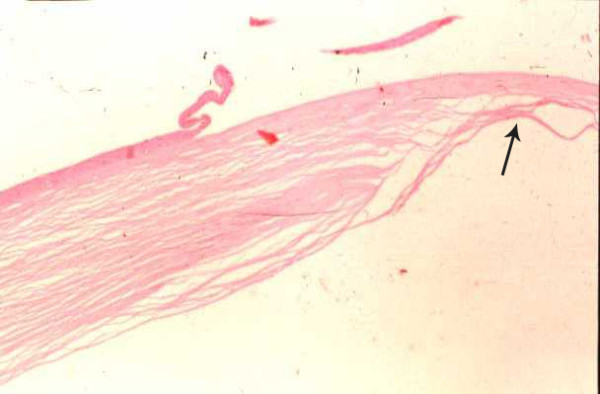
Section of corneal button of case 4 showing marked thinning in the central stroma (descematocele, arrow).